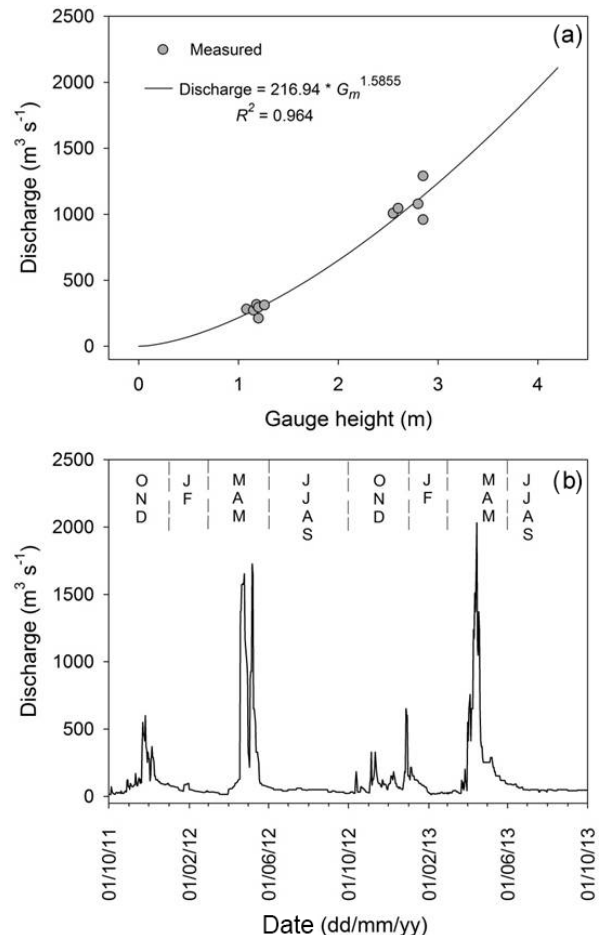
Figure 2. (a) Discharge rating curve for the Sabaki River at the Baricho gauge station (3HA13). (b) Calculated daily discharge for the 2-year monitoring period. Note the one anomalous gauge read- ing on the 12 November 2012 provides an upper discharge estimate of 41332m 3 s − 1 , over a magnitude larger than the next highest daily discharge estimate (3441m 3 s − 1 ) . Given the discharge esti- mates on the preceding (11 November 2012) and following days (13 November 2012) were 312 and 218m 3 s − 1 respectively and also re- ported historical maximum daily discharge of ∼ 5000m 3 s − 1 (Delft Hydraulics, 1970), we linearly interpolated the gauge data for the 12 November 2012 from the values of adjacent days thereby lower- ing the discharge estimate for this date to 249m 3 s − 1 . The curve in (a) was developed from the limited dataset ( n = 11) of recent dis- charge measurements (2006–2007; grey circles) on the Sabaki River at Baricho (data supplied by WRMA,